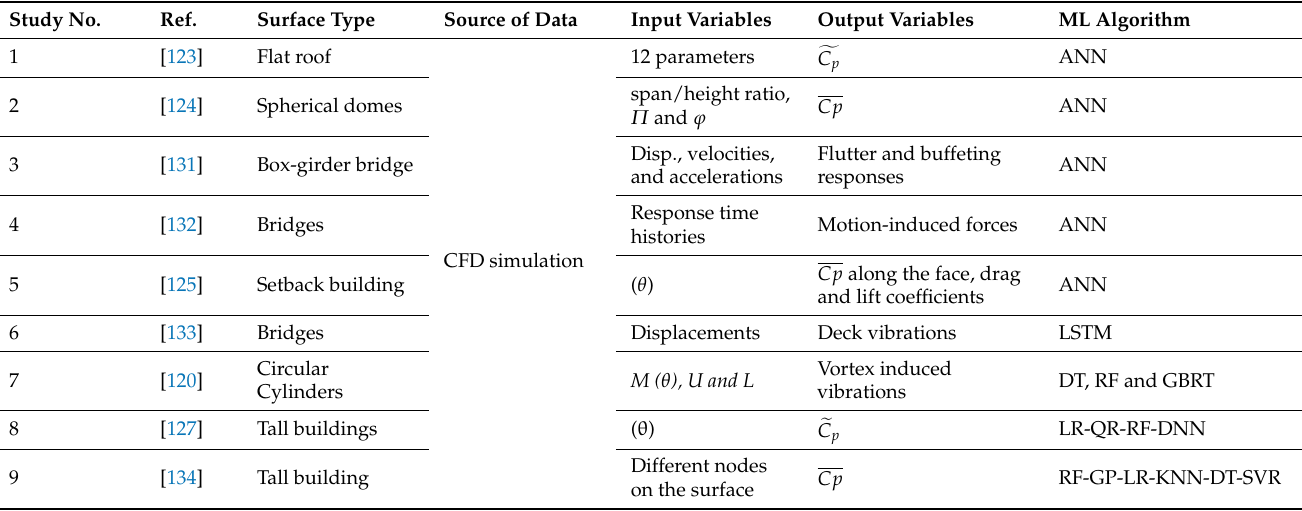
Table 2. Summary of studies reviewed for integrating ML models with CFD